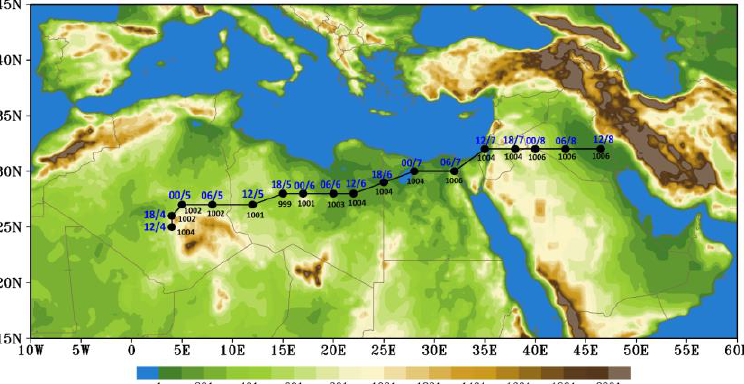
Figure 1. The track of the desert depression during the period from 12Z04 to 12Z08 April 2007. The black numbers are the values of pressure at the center of the depression every six hours, and the blue numbers are the time during the period from 12Z04 to 12Z08 April 2007. The shaded areas represent the elevation of the surface topography (m).